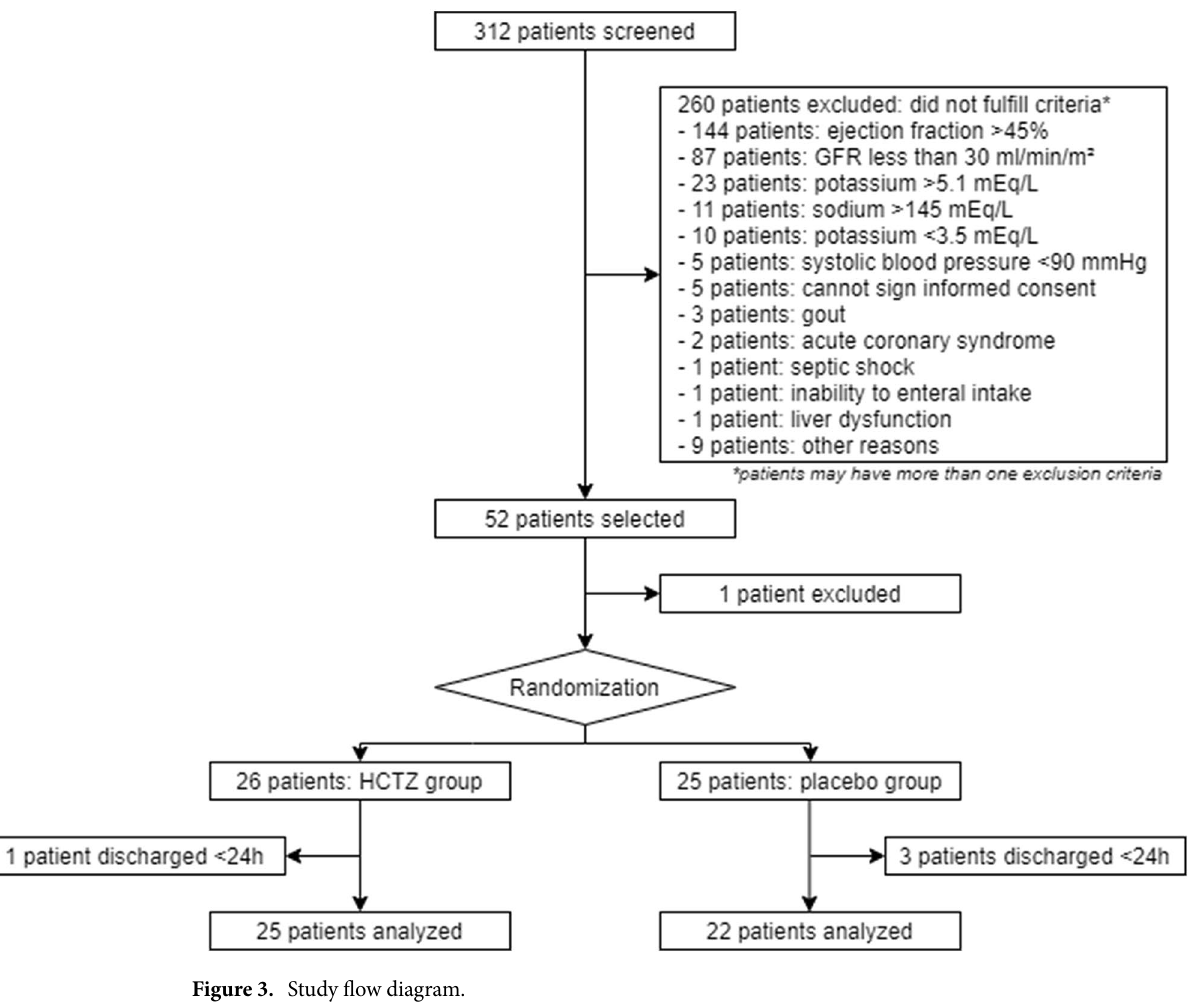
Figure 3. Study flow